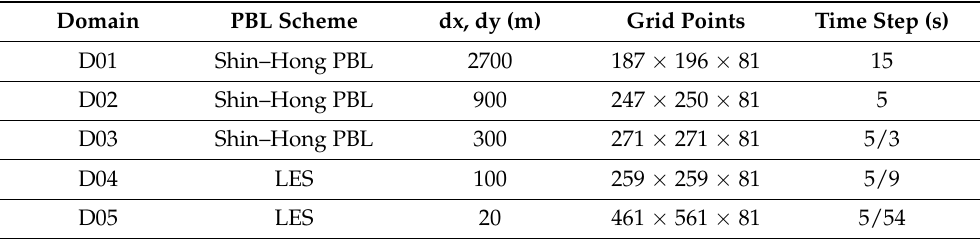
Figure 6. Domain configuration of WRF–LES and implementation of high-resolution domestic land-cover data. Table 1. WRF–LES specification for each domain.